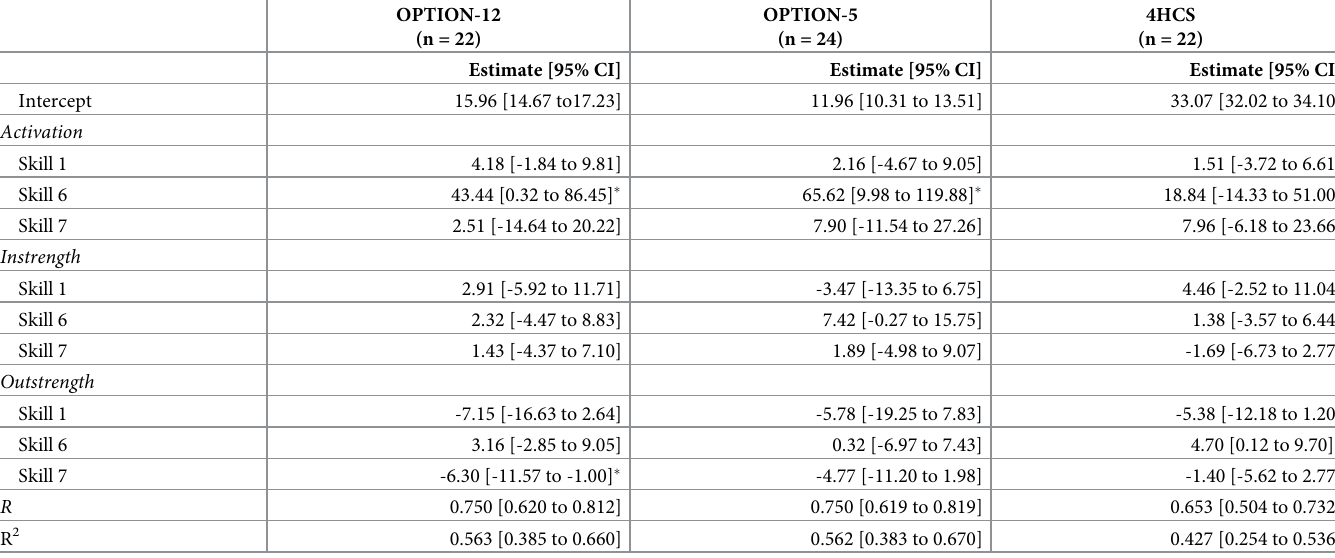
Table 3. Confirmatory prediction of observed SDM competence from network